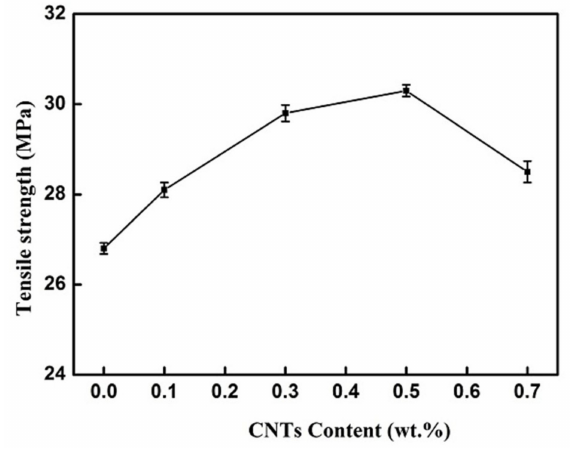
Figure 4. Tensile strength of CNT-BF / EP modified by di ff erent additions of the